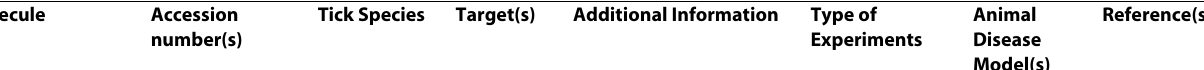
Table 1. Anticoagulants and Immunosuppressors in Tick